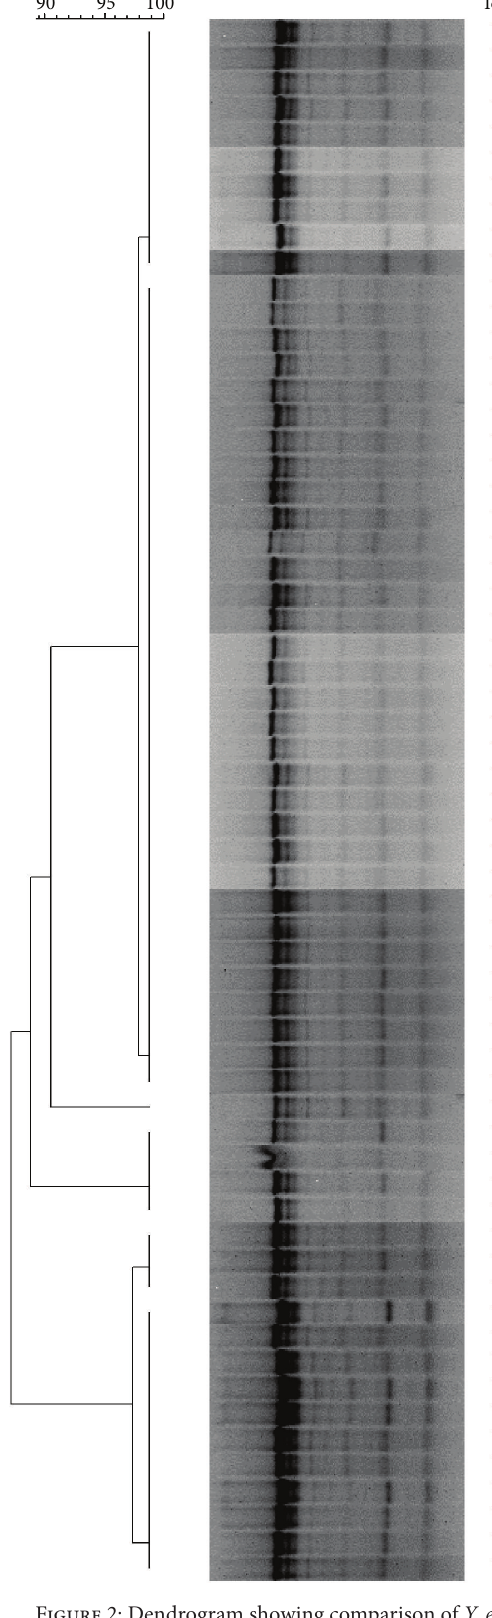
Figure 2: Dendrogram showing comparison of Y. enterocolitica biotype 4/O:3 isolates by